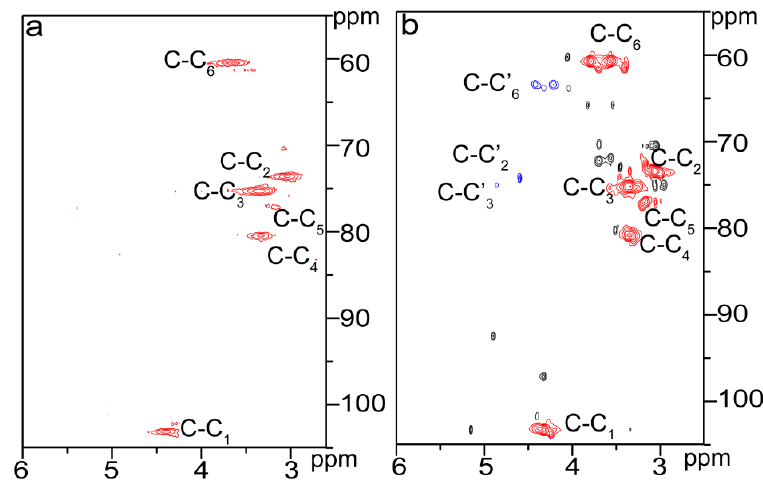
Figure 5. 2D HSQC NMR spectra of unmodified (C0, a ) and esterified (C5, b ) cellulose.